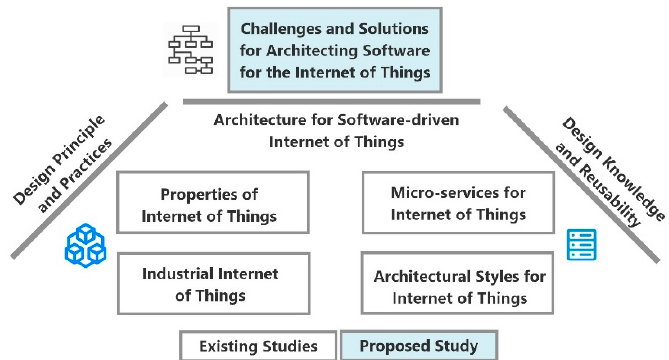
Figure 3. Comparison Overview of the Existing vs. Proposed Study on Architecting IoT Software.